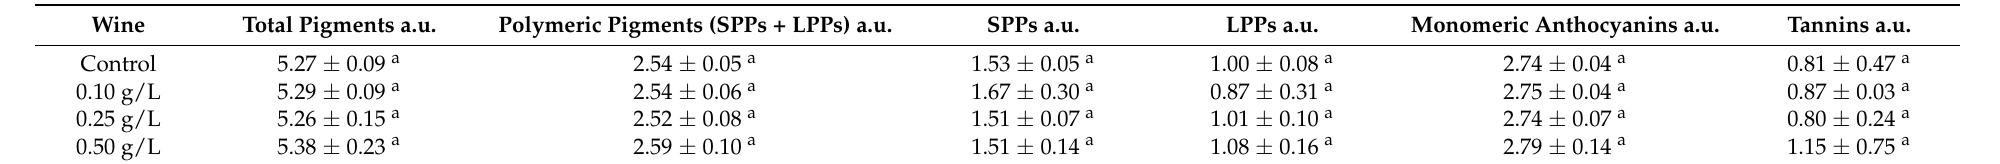
Table 3. Total pigments, polymeric pigments, small polymeric pigments (SPPs), large polymeric pigments (LPPs), monomeric anthocyanins, and tannins of red wines after applying different doses of ADSI cork powder (0.10, 0.25, and 0.50 g/L).